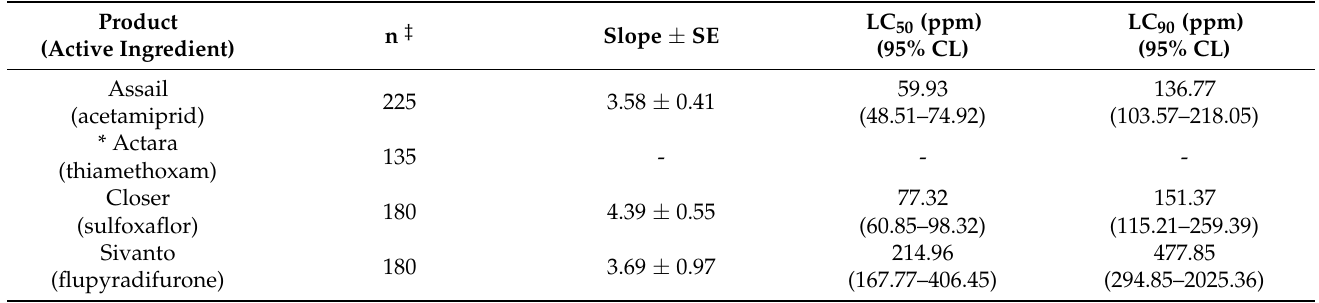
Table 1. Response curve slopes, LC 50 , and LC 90 values for different pesticides using mortality observations at 48 h